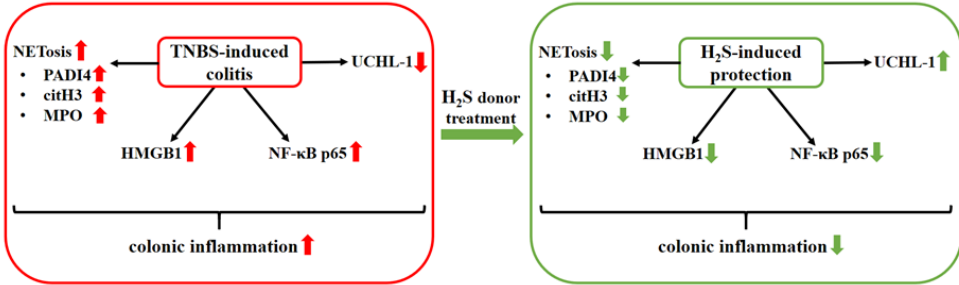
Figure 8. Summary of the presumed protective action of H 2 S donor treatment in experimental rat colitis. 2,4,6-trinitrobenzenesulfonic acid (TNBS); hydrogen sulfide (H 2 S); peptidyl arginine deiminase 4 (PAD4); citrullinated histone H3 (citH3); myeloperoxidase (MPO); high-mobility group box 1 (HMGB1); nuclear transcription factor-kappa B p65 subunit (NF- κ B p65); ubiquitin C-terminal hydroxylase L1 (UCHL-1).